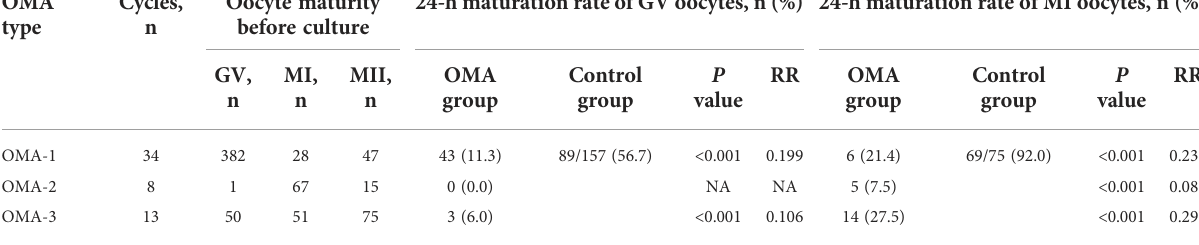
TABLE 2 Comparison of 24-h maturation rates between oocytes from patients with and without OMA. OMA type